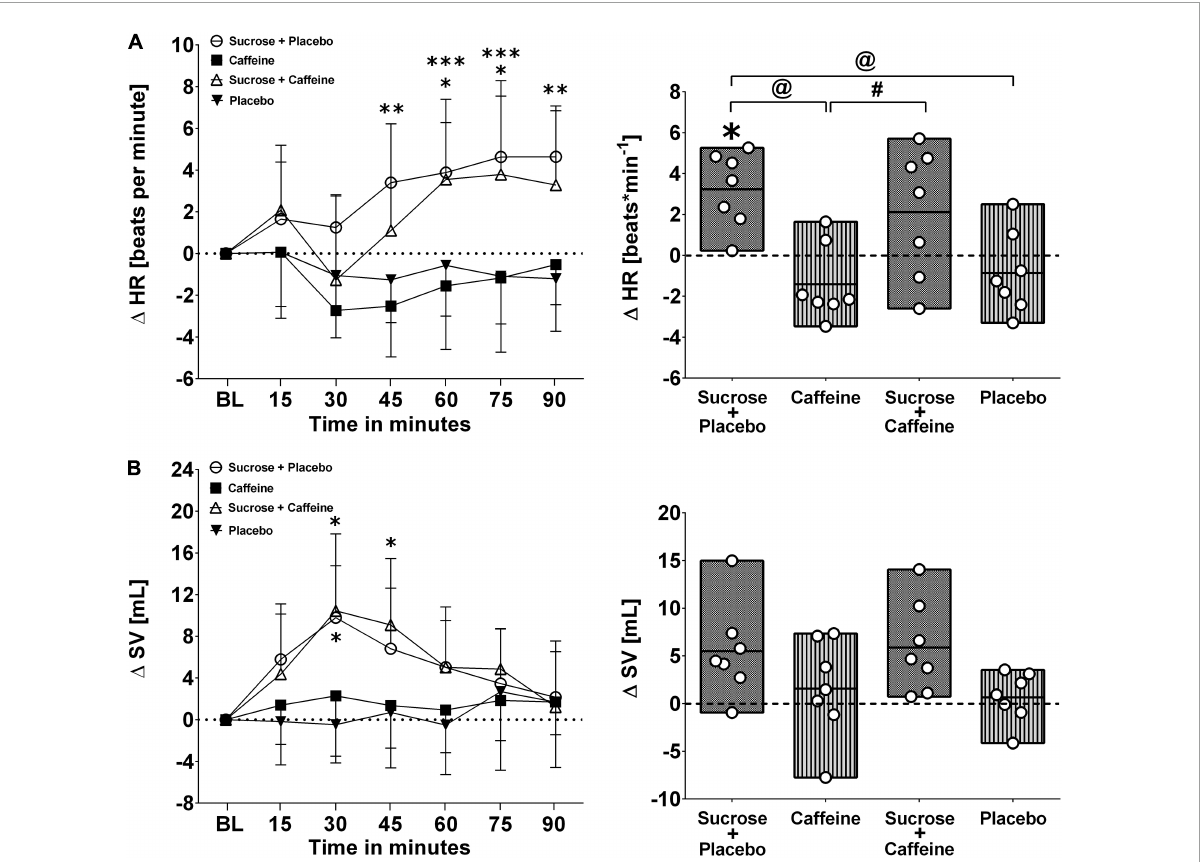
FIGURE2 Left panels (A,B) : Time course for changes in heart rate (HR) and stroke volume (SV) in response to the four drinks. Each mean value (i.e., 15-min blocks) corresponds to the average over the respective interval that was subtracted by its baseline (BL) values. Data are presented as means ± standard deviation. Right panels (A,B) : Boxes (minimum to maximum values) represent individual mean responses (open circles) averaged over 90 min post-drink and subtracted by baseline values for each drink, respectively. In both panels, asterisks show statistically significant differences over time from baseline values (both panels) at ∗ p < 0.05, ∗∗ p < 0.01, and ∗∗∗ p < 0.005. For right panels only, # p < 0.05 and @ p < 0.01 represent statistically significant differences between responses to the drinks as analyzed by one-way repeated measures analysis of variance with Holm–Sidak’s post hoc